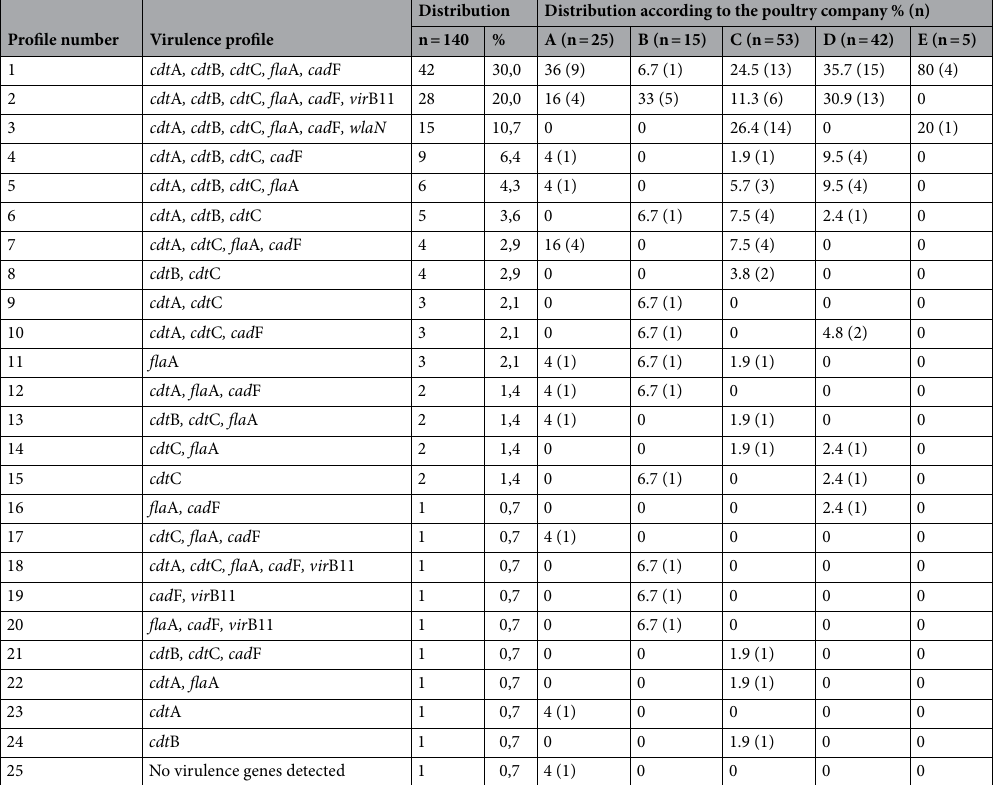
Table 1. Distribution of virulence profile among Campylobacter jejuni strains.